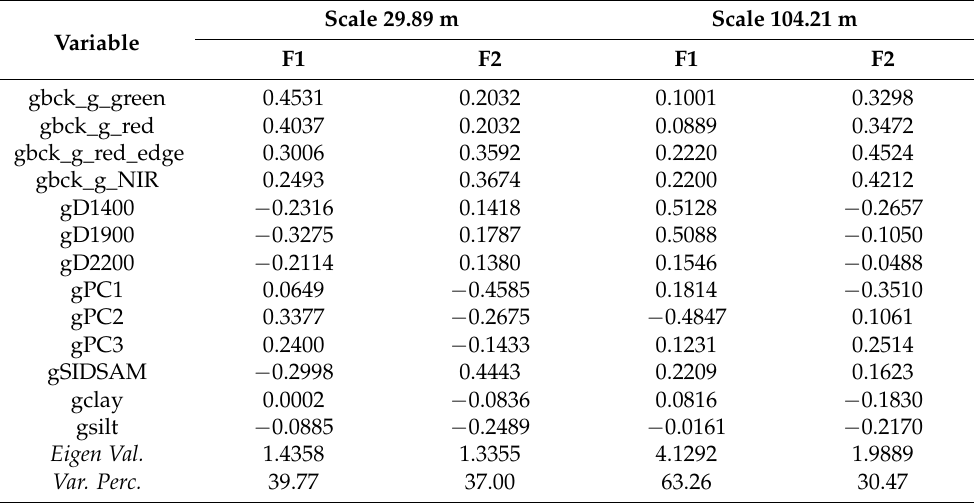
Table 6. Structure of the first two regionalized factors at short range (29.89 m) and of the first two regionalized factors at long range (104.91 m), shown with the corresponding loading coefficients, the eigen value and the percentage of explained variance. g before the name of the variable stands for Gaussian-transformed variable. Scale 29.89 m Scale 104.21 Variable